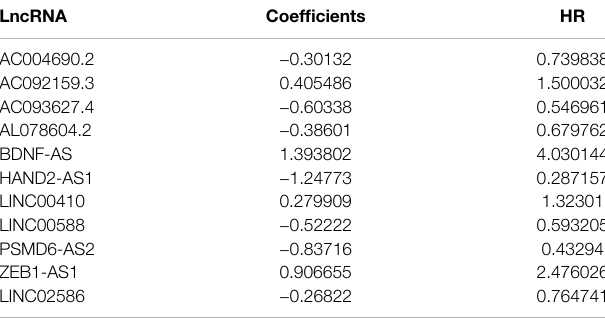
TABLE 2 | The 11 autophagy-related lncRNAs signi fi cant by multivariate Cox analysis.